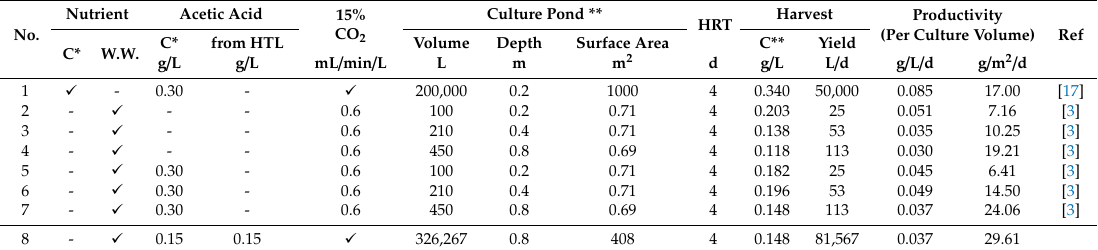
 0.30 under all conditions.